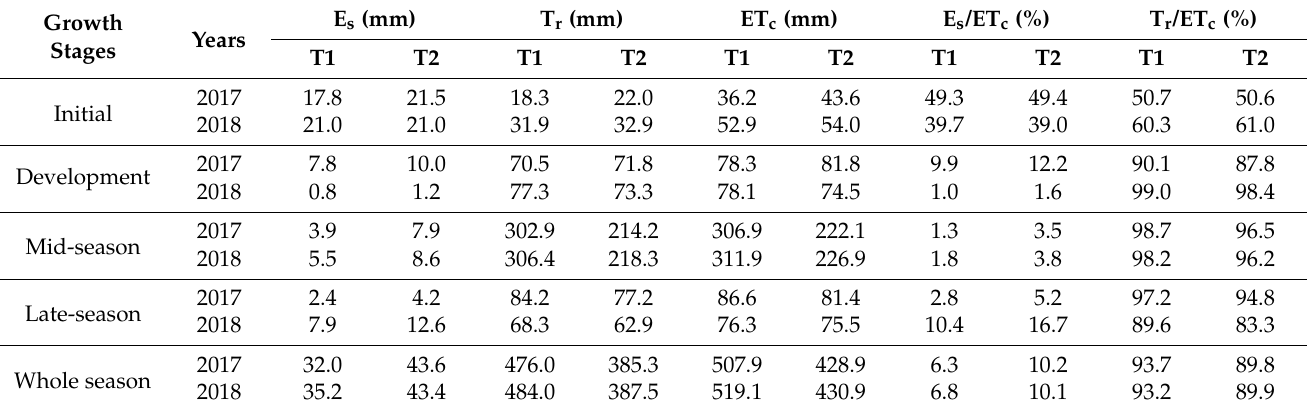
Table 6. Soil evaporation (E s ), transpiration (T r ), evapotranspiration (ET c ) and ratios of evaporation and transpiration to evapotranspiration for the two treatments (T1 and T2) at different growth stages of maize in 2017 and 2018. Growth